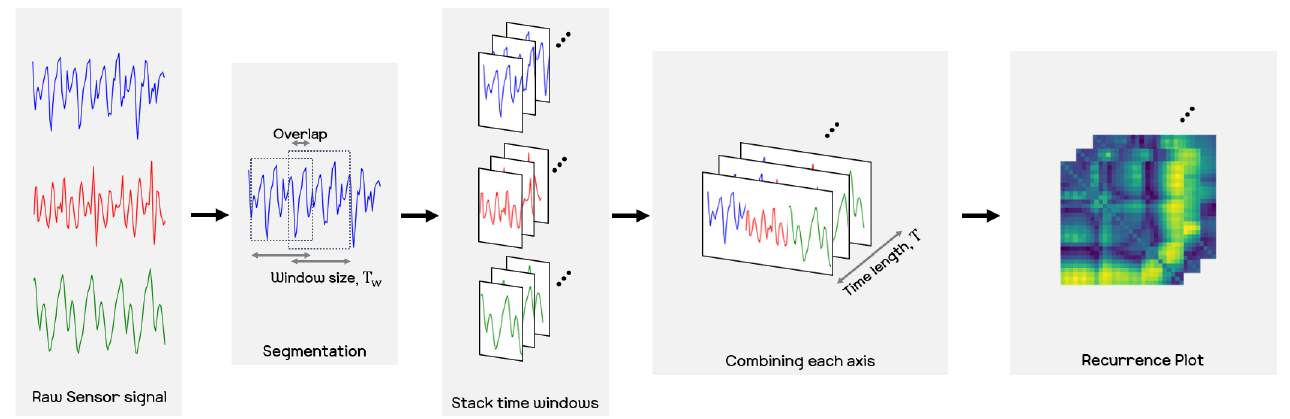
Figure 7. Procedure for converting raw sensor signals into a recurrence plot. Raw sensor signals are divided into time windows of size T w and then converted into a recurrence plot by combining time windows corresponding to each x-, y-, and z-axis into one.